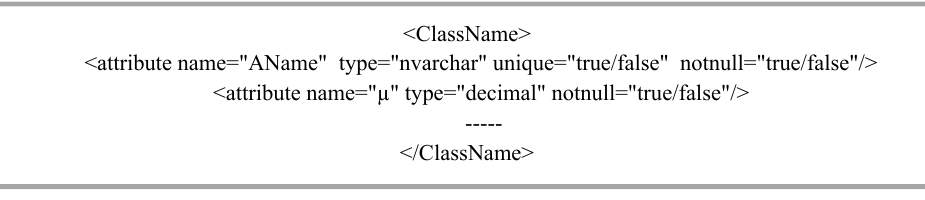
Fig. 1. Create a class syntax with XML